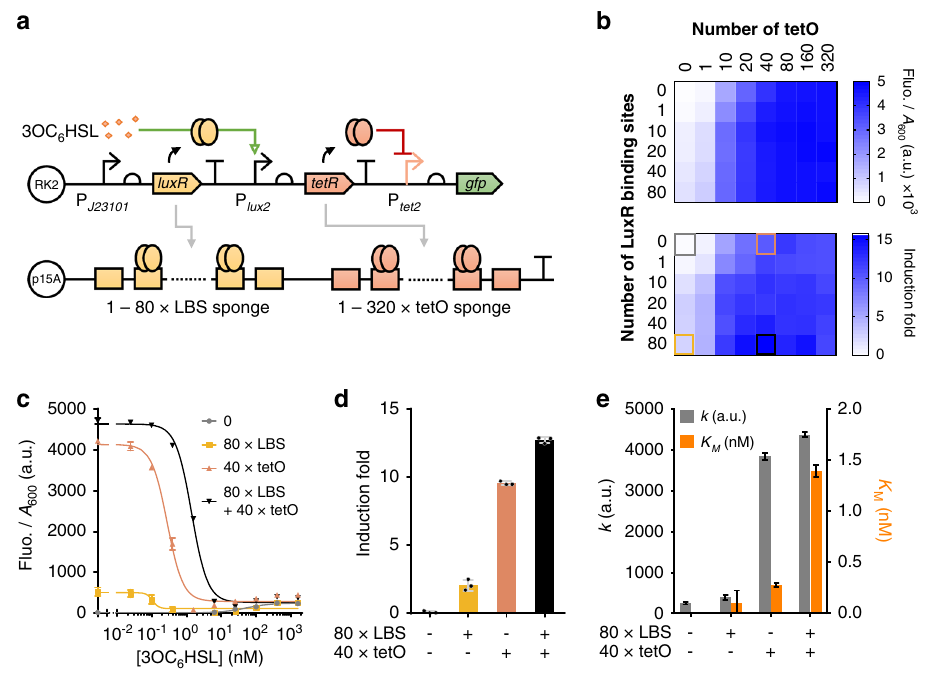
Fig. 4 Tuning response of a layered circuit using multi-layer DNA sponges to decoy regulators within both the input sensing and signal processing modules. a Schematic of using dual-layer DNA sponges to tune the response of a layered circuit consisting of an AHL-responsive input sensor connected with a downstream TetR-based inverter. Sponges containing 1 – 80 repeats of the LuxR binding site (LBS) and 1 – 320 repeats of the TetR operator (tetO) are combined to decoy LuxR and TetR within the input sensing and signal processing modules respectively. b Output gene expression and induction fold of the AHL-responsive circuit with regulation by the LBS-tetO dual-layer sponges. Output gene expression (top panel) is obtained when there is no AHL induction, indicating leaky expression of TetR repressor (the higher the output, the lower the TetR leakage). Induction fold (bottom panel) is calculated using the output fl uorescence intensity of the none-induced samples (top graph) divided by the fl uorescence intensity of samples induced by 1.6 μ M 3OC 6 HSL (Supplementary Fig. 11a). c Dose-responses of the two-layered AHL-responsive circuit with regulation by four different LBS-tetO sponges selected from ( b ). d Induction fold between uninduced and samples induced by 1.6 μ M 3OC 6 HSL of the circuit characterized in ( c ). e Hill constant ( K M ) and maximum output ( k ) of the circuit ’ s dose-responses characterized in ( c ). K M value of sample ( − / − ) is not shown due to insuf fi cient dose-response of the circuit. For ( b ), values are mean ( n = 3 biologically independent samples). For ( c , d ), values are mean ± s.d. ( n = 3 biologically independent samples). For ( e ), values are mean ± s.e.m. ( n = 3 biologically independent samples). Fluo., fl uorescence. a.u., arbitrary units. Source data are provided as a Source Data fi